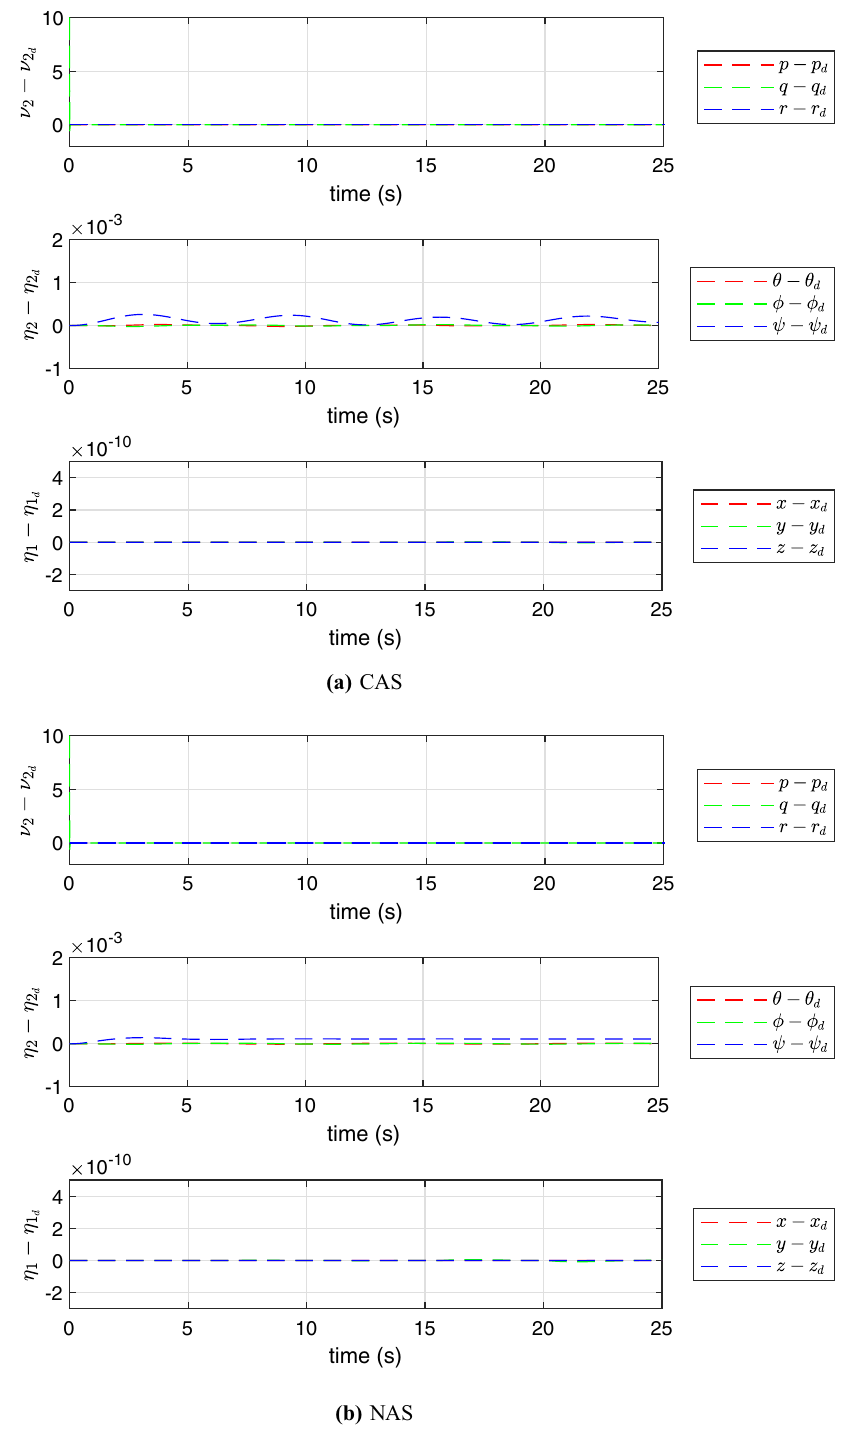
Figure 8. The profile of the trajectory tracking